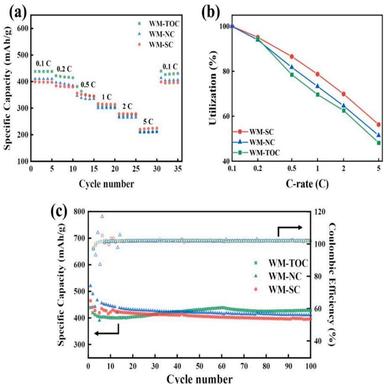
Cell performance of WM-SC, WM-NC and WM-TOC: (a) rate capability from 0.1 C to 5 C; (b) capacity utilization based on 0.1 C value and (c) cycle performance at 0.1 C/0.1 C-rates.